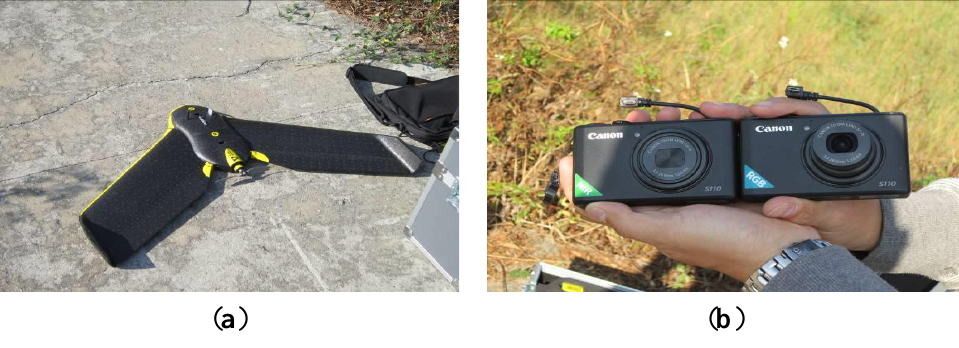
Figure 3. UAV imagery system: ( a ) Fixed-wing UAV; ( b ) RGB ( right ) and NIR ( left )